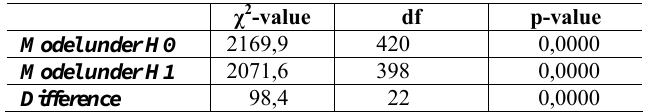
Table 11: Discriminant validity results: Sample 1